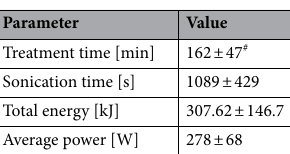
Table 3. Intervention parameters of the HIFU treatment. # Mean ± standard deviation values are